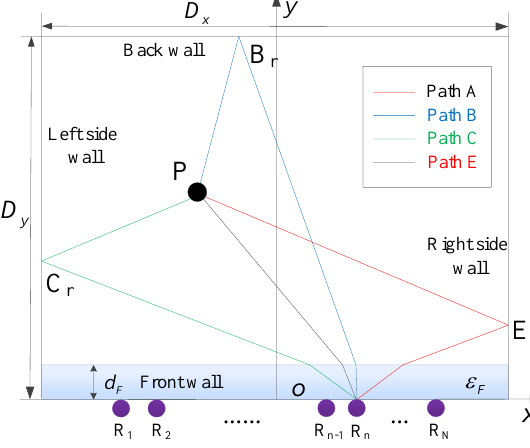
Figure 1. An illustration of the multipath